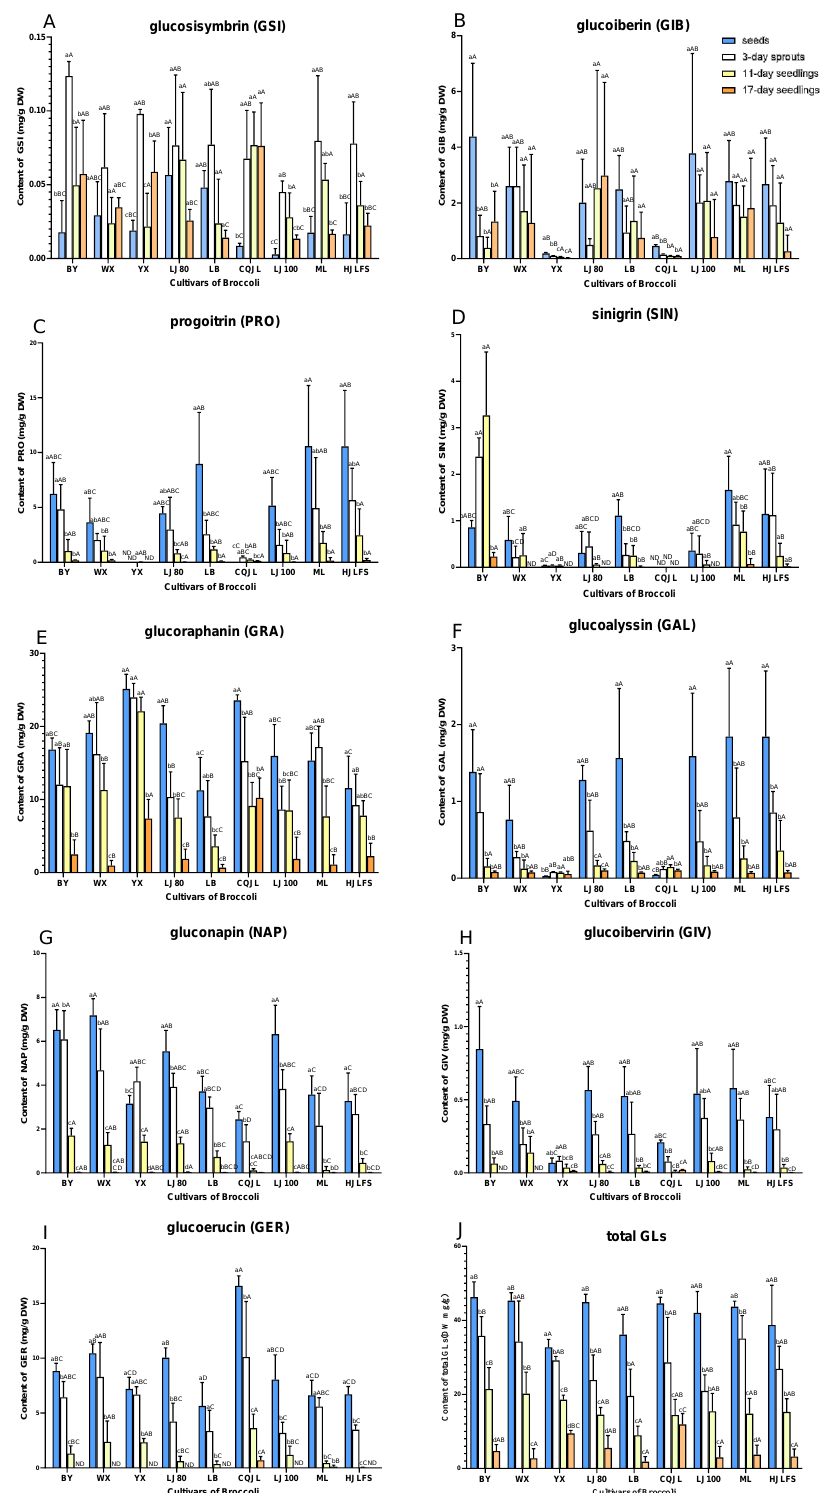
Figure 3. Contents of aliphatic GLs ( A – I ) and total GLs ( J ) in different cultivars of broccoli at various developmental stages. ( A ), Glucosisymbrin (GSI); ( B ), Glucoiberin (GIB); ( C ), Progoitrin (PRO); ( D ), Sinigrin (SIN); ( E ), Glucoraphanin (GRA); ( F ), Glucoalyssin (GAL); ( G ), Gluconapin (NAP); ( H ), Glucoibervirin (GIV); ( I ), Glucoerucin (GER); ( J ), total GLs. The different lowercase letters indicated significant differences ( p < 0.05) of values in different stages in the same cultivar. The different uppercase letters indicated significant differences ( p < 0.05) of values in cultivars in the same developmental stage. Values are expressed as mean ± standard deviation (SD) (n = 5) .